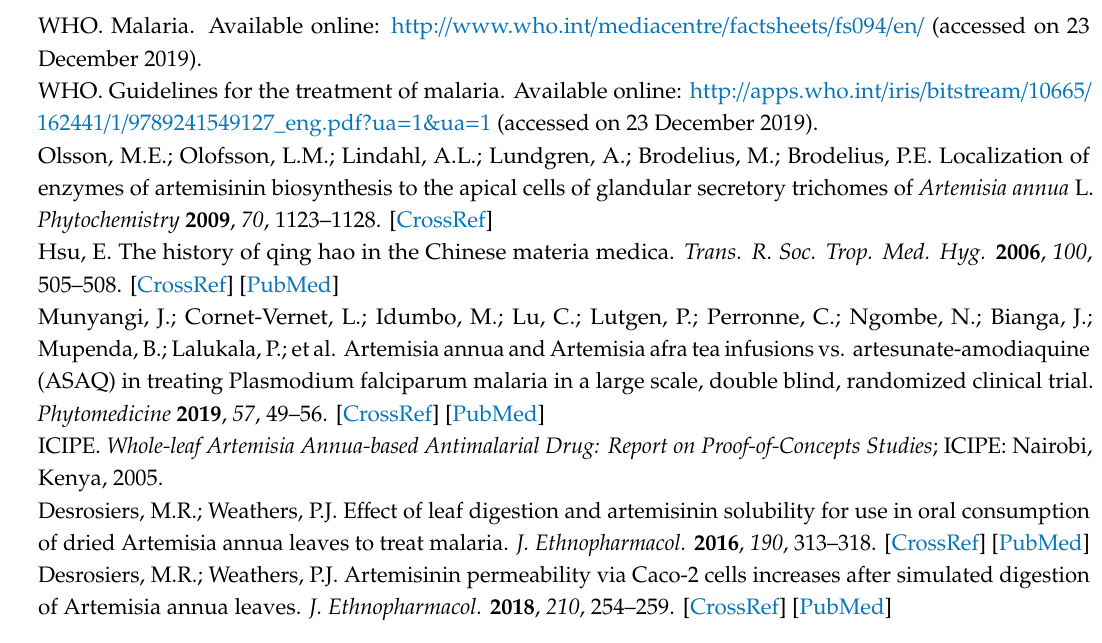
Figure S1: Artemisinin (AN) and deoxyartemisinin (DeoxyAN) accumulation in feces of male ( A , B ) and female ( C , D ) rats after oral delivery of artemisinin as dried leaf A. annua (DLA) or pure artemisinin. n = 7–8, *; p < 0.05; error bars = SEM., Figure S2: Production of anti-inflammatory cytokine IL-10 in male ( A ) and female ( B ) rats after LPS challenge and treatment with either pure artemisinin (AN) or DLA (equal artemisinin doses). n = 5–6 for experimental conditions, n = 3 for injection control; error bars = SEM, Table S1: Microbiome population by Phylum 1 h and 8 h after treatment with DLA or pure artemisinin in male